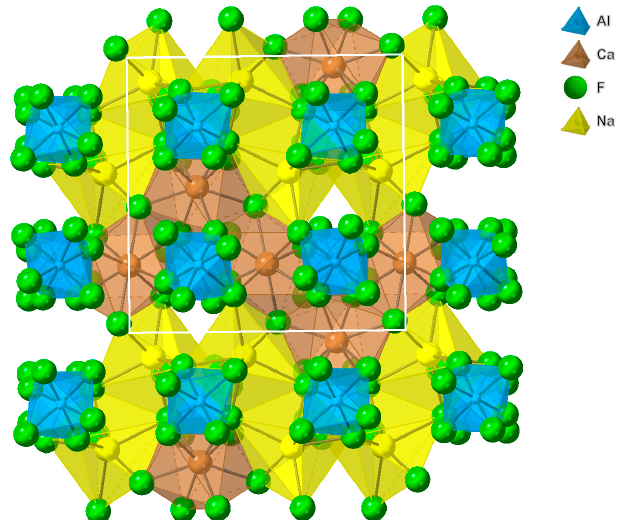
Figure 4. A {100} layer from the crystal structure of verneite, formed by sinuous chains of Ca coordinations and Na coordinations, and overlaid/underlain by the [AlF 6 ] octahedra. Projection based on crystal structure data from Reference [13].